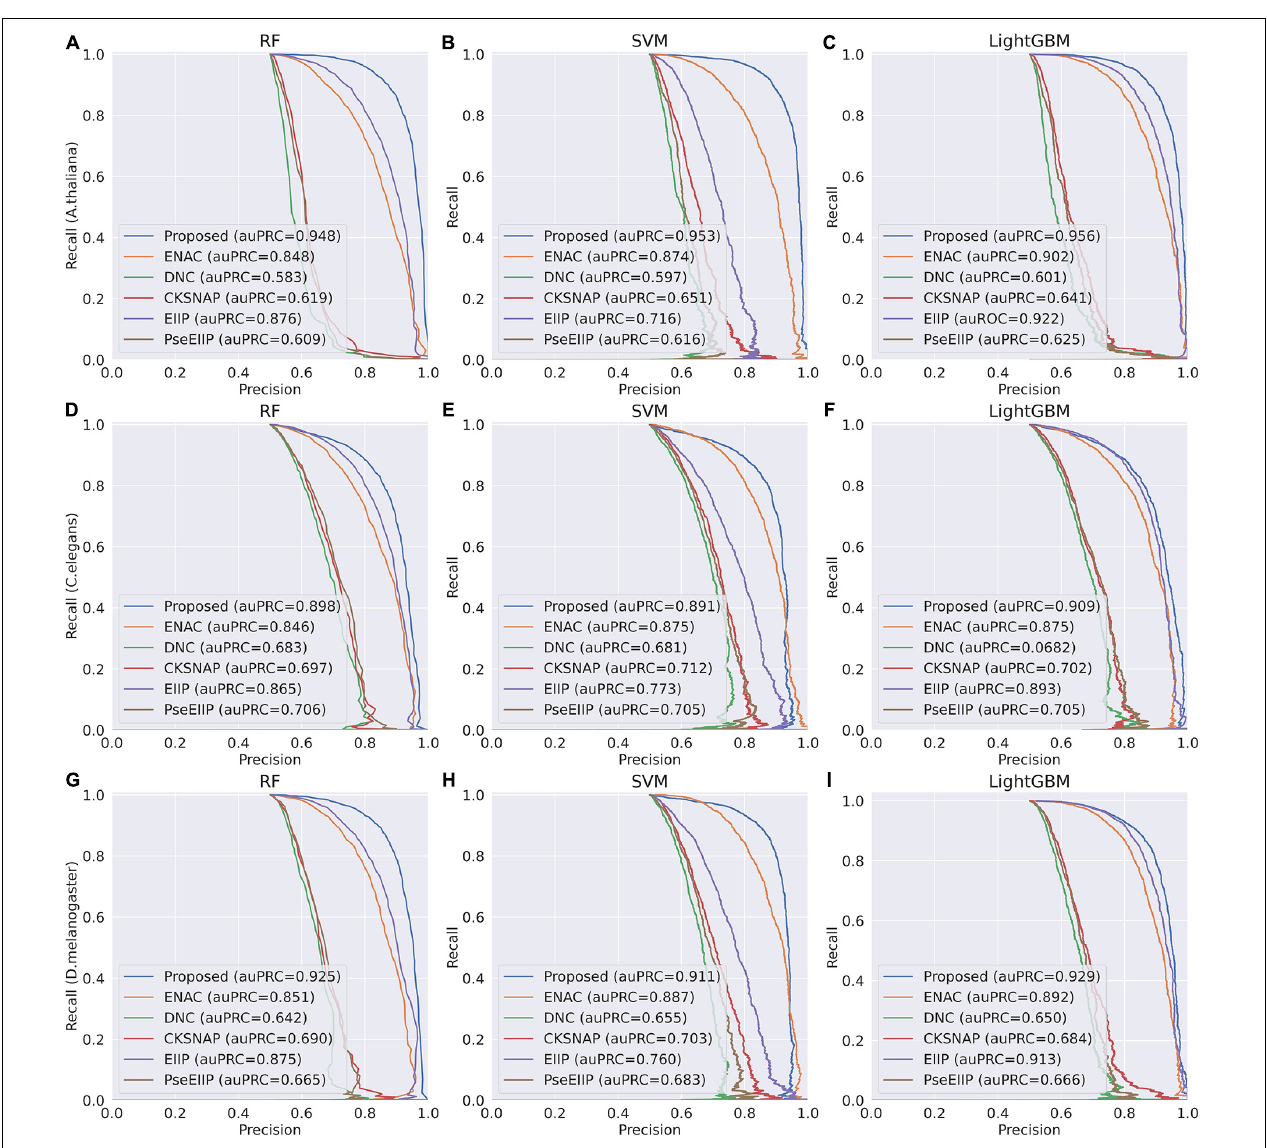
FIGURE 5 | PR curves of the Proposed, ENAC, DNC, CKSNAP, EIIP, and PreEIIP methods are based on the three basic classifiers for each species. (A–C) The results of the species A. thaliana . (D–F) The results of the species C. elegans . (G–I) The results of the species D. melanogaster.